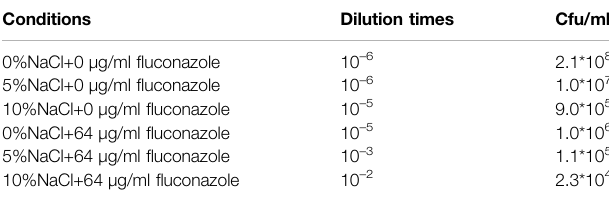
TABLE 2 | Drug resistance of GXDK6 to fl uconazole under NaCl